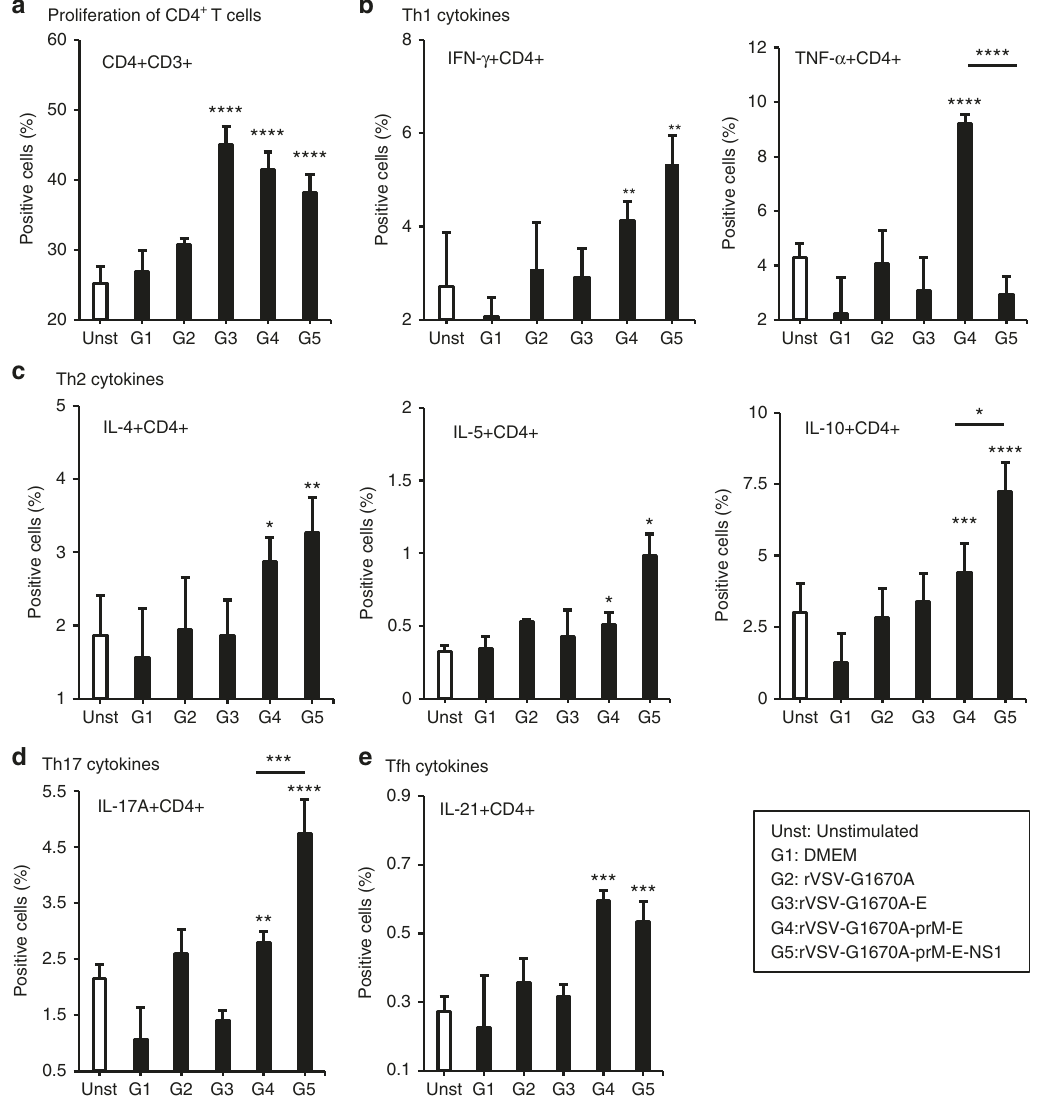
Fig. 3 MTase-defective rVSV (mtdVSV)-based vaccine induces ZIKV-speci fi c T helper cell responses. Six-week-old BALB/c mice were immunized with each vaccine candidate (5 mice per group). Mice were euthanized at day 35 post-immunization, the spleen was isolated from each mouse, homogenized, a cell suspension prepared, split into three wells (triplicate per mouse) and cultured in 96-well microtiter plates in the presence of 20 µ g/ml of ZIKV E protein for 5 days. a Proliferation of CD4 + T cells. The frequencies of ZIKV-speci fi c Th1 (IFN- γ + CD4 + and TNF- α + CD4 + ) ( b ), Th2 cells (IL-4 + CD4 + , IL-5 + CD4 + ) ( c ), Th17 (IL-17A + CD4 + ) ( d ), and Tfh (IL-21 + CD4 + ) ( e ) cells were determined by fl ow cytometry after intracellular staining with the corresponding anti-cytokine. Data were expressed as mean % positive cells (the mean of 15 samples: 3 wells × 5 mice) ± standard deviation. Asterisk indicates that the group was statistically different with unstimulated and DMEM groups. P -value in from left to right for each panel by Student ’ s t